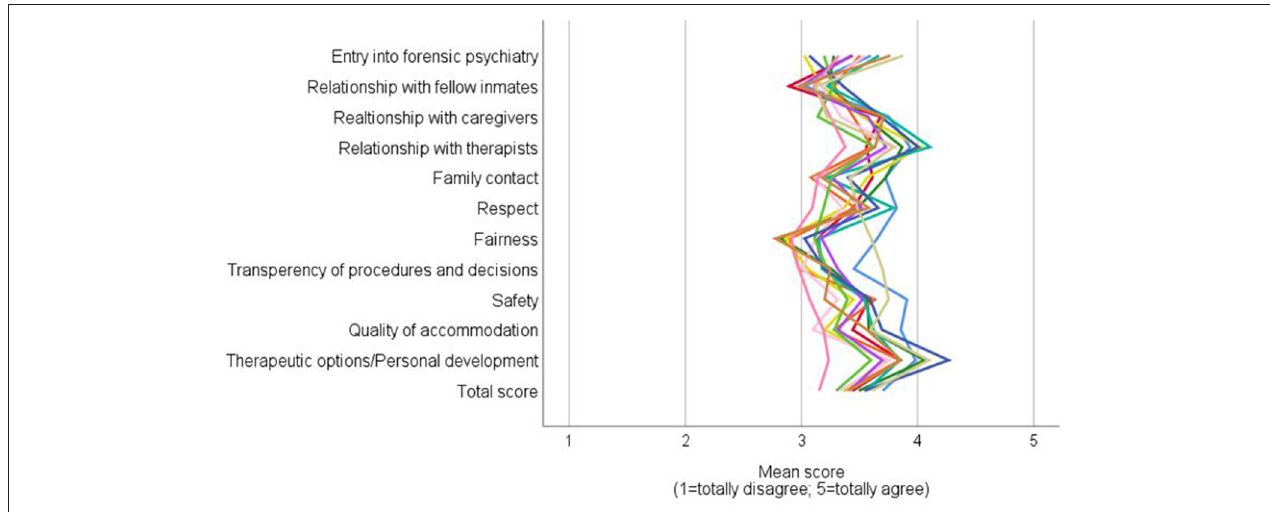
FIGURE 1 | Mean values of the 13 participating Bavarian forensic psychiatric hospitals across the individual subscales and the total score of the aMOPL.